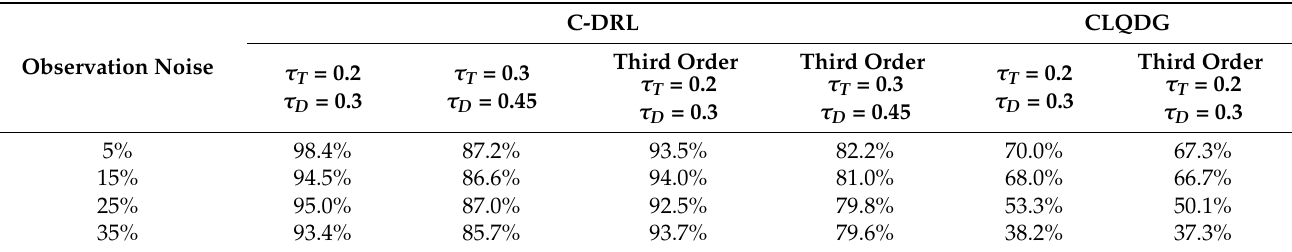
Table 6. Success rate under uncertainty